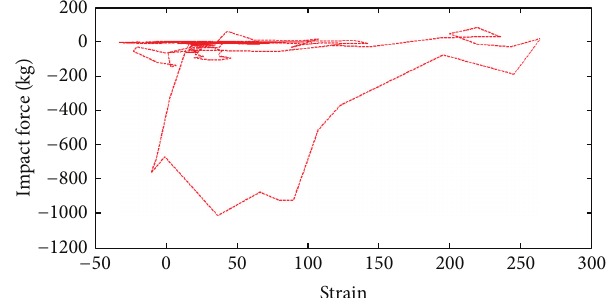
Figure 2: Nonlinear behavior of an MR damper under high impact